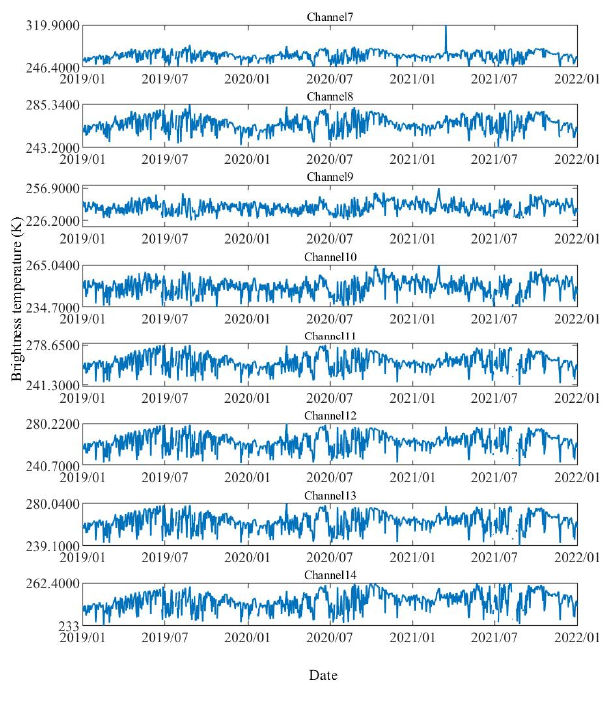
Figure 3. The pre-processed data at 99.13 ◦ E, 29.68 ◦ N.